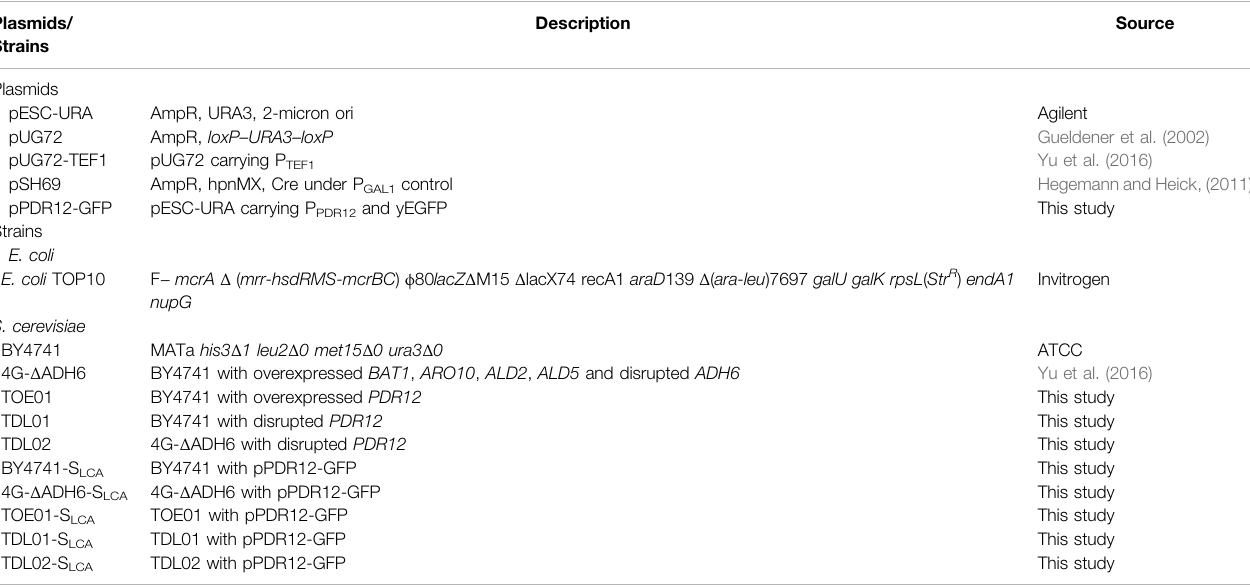
TABLE 1 | Plasmids and strains used in this